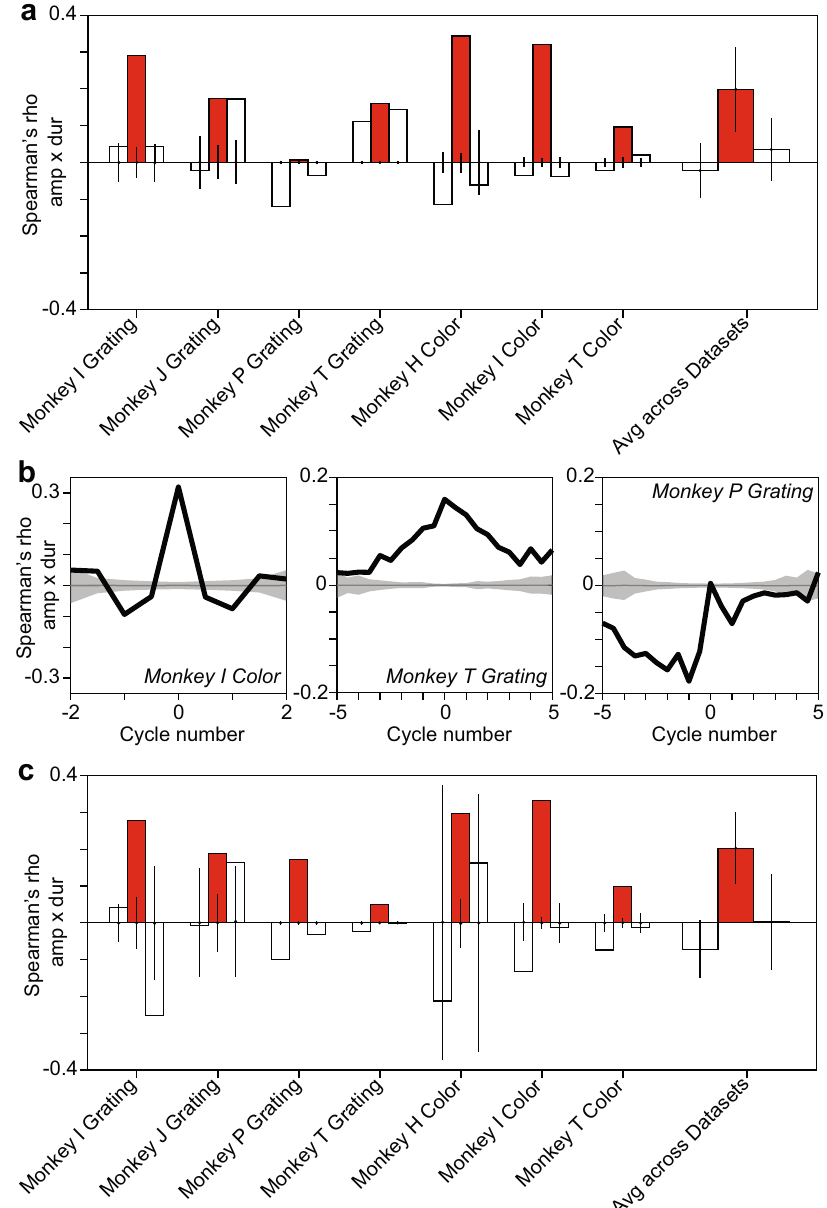
Fig. 4 Gamma-half-cycle amplitudes and durations are positively correlated in gamma-oscillatory epochs. a For each dataset listed on the x-axis, the three bars show the correlation between the amplitude of a gamma half cycle and the duration of the same (center, red), previous (left, white), and next (right, white) gamma half cycle. On the right, this is shown for the average across all datasets. This was calculated for each time point across trials and averaged across time points for gamma-oscillatory epochs. The data used correspond to the period during the presentation of the visual stimulus. For individual datasets, a null distribution was produced by randomizing the order of duration values across trials, and the resulting means and 99.9% con fi dence intervals are shown as dots and vertical lines (numbers of trials = 278, 5740, 672, 1075, 672, 320, 142 for respective datasets). For the average across datasets, shown on the right, we performed a two-sided t -test and show the resulting con fi dence intervals as vertical lines on the observed mean (red bar: p < 6 × 10 − 3 , white bars for preceding cycle: p = 0.5, white bars for succeeding cycle: p = 0.35). In addition we performed a two-sided non- parametric permutation test (red bar: p < 0.05; white bars: p > 0.05). b Correlation between the amplitude of a gamma half-cycle and the duration of gamma half-cycles before and after it for three different datasets. Note that in monkey I, this is limited to ±2 cycles, because the signal-to-noise ratio was lower, resulting in shorter gamma-oscillatory epochs. Importantly, all three example datasets show a central peak, despite the fact that they show different longer-term correlations. The gray lines and gray-shaded areas depict the means and 99.9% con fi dence regions, after randomizing the order of duration values across trials. c Same as a , but showing the correlations between residuals of the regression across adjacent amplitude triplets and the residuals of the regression across adjacent duration triplets (numbers of trials = 278, 5740, 672, 1075, 672, 320, 142 for respective datasets; red bar: p = 23 × 10 − 4 , two-sided t-test across datasets; p < 0.05, permutation test for individual datasets; white bars p = 0.066 and p = 0.97, respectively for preceding and succeeding cycles, two-sided t -test across datasets; p > 0.05, permutation test for individual datasets). a – c : n = 6 biologically independent experiments. Source data are provided in the Source Data fi